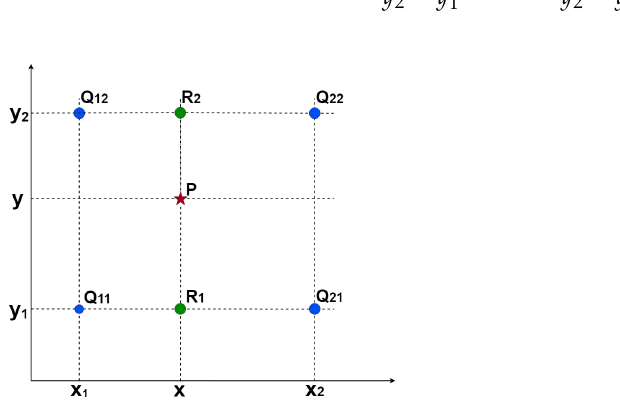
Figure 4. This is the example of bilinear interpolation. The red star P is our target. To obtain the target, we first calculate the pixel value of R 1 and R 2 by interpolating in the x direction using a weighted average of ( Q 11 , Q 21 ) and ( Q 12 , Q 22 ) , respectively, and then interpolate in the y direction according to R 1 and R 2 to find the value of P